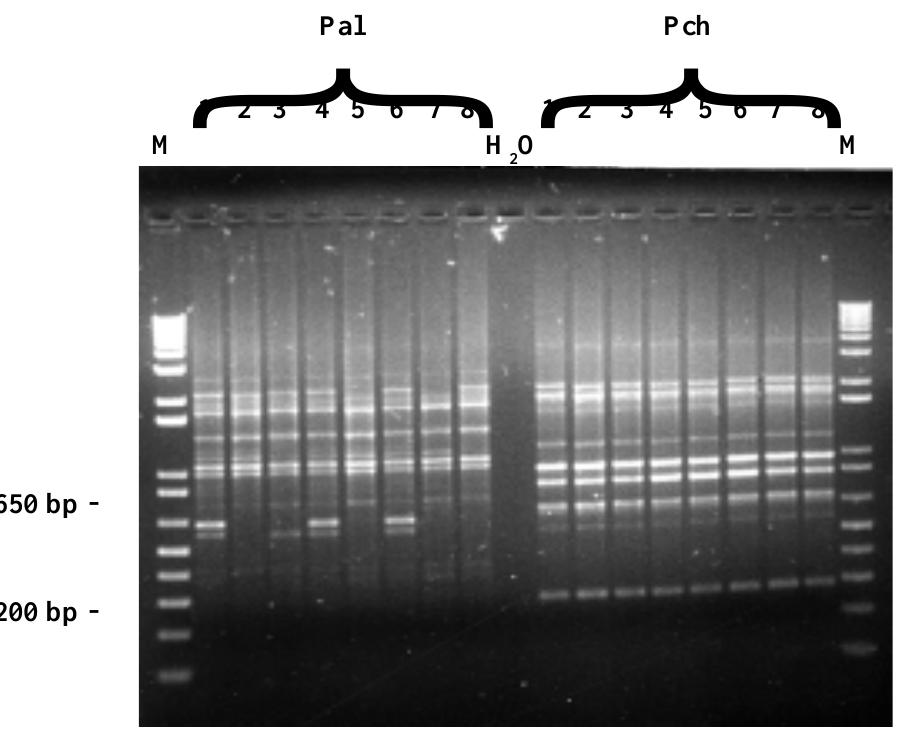
Fig. 3. Gel electrophoresis of the PCR products obtained with primer M13 with Pal and Pch isolates. Lanes M, 1kb Plus DNA Ladder (Gibco-BRL, Life Technologies); lane H